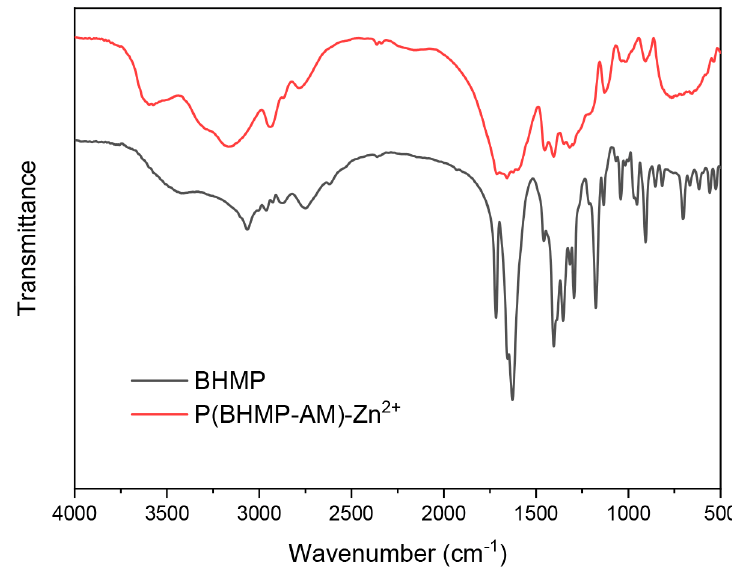
Figure 2. FTIR spectra of BHMP and the P(BHMP-AM) − Zn 2+